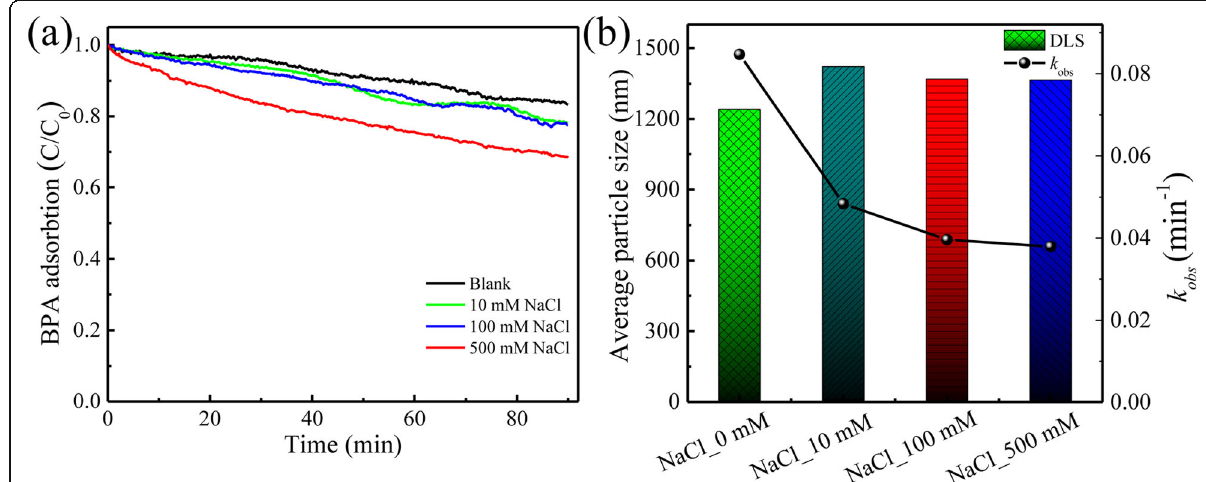
Fig. 5 ( a ) Sedimentation curve of ZnO NPs after loading different NaCl concentration, ( b ) effect of NaCl on average particle size distribution of ZnO NPs and the photocatalytic degradation rate